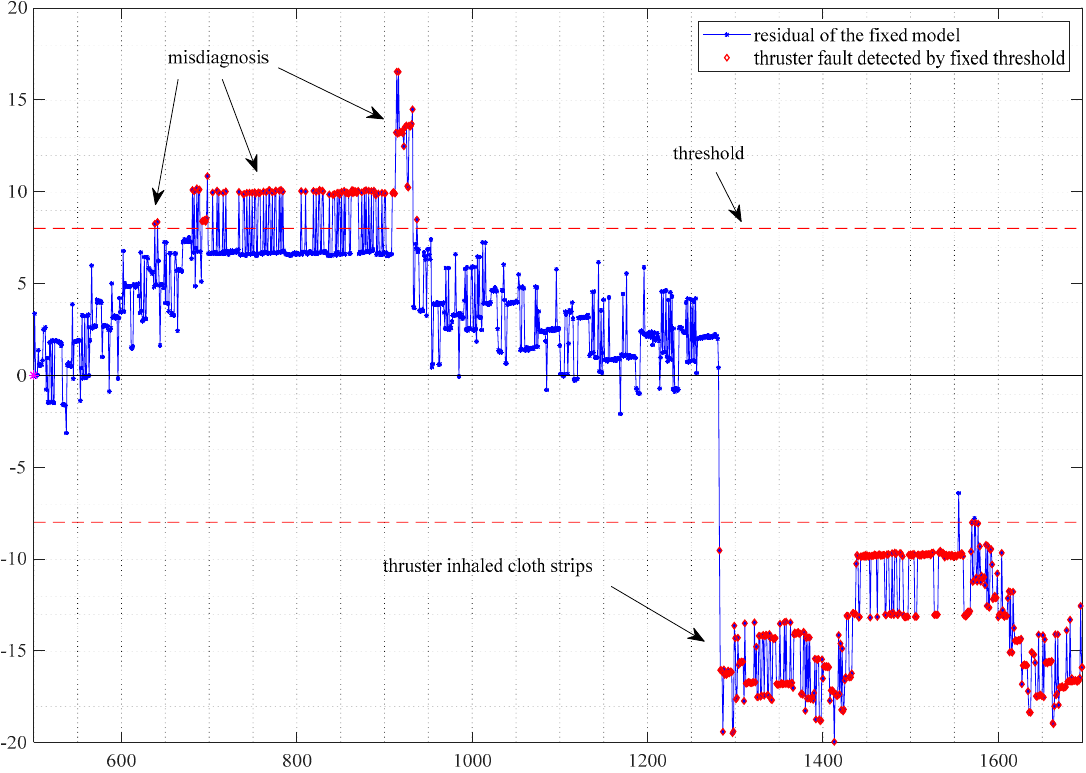
Figure 15. Model residuals of the fixed model-based fault detection method during pool test of the saucer-shape AUV.